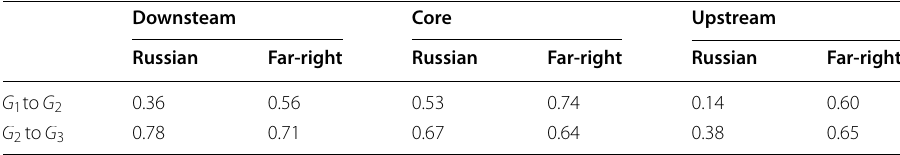
Table 9 Rank-biased overlap similarity (RBO) (Webber et al. 2010) between the ranked domain lists of the first and second networks (first row), and second and third networks (second row) of the downstream, core and upstream Russian and far-right communities Downsteam Core Upstream